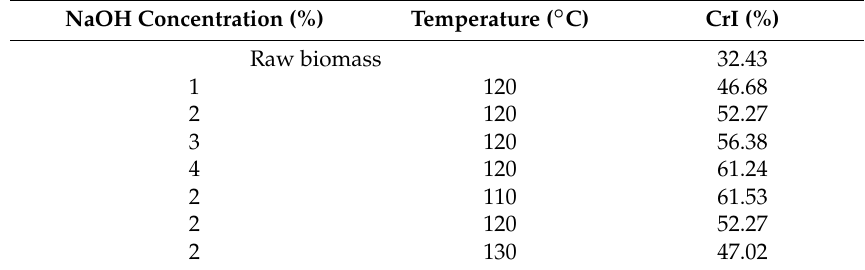
Table 4. The crystallinity index (CrI) of the raw and autoclave-assisted alkaline pretreated C. barbata . NaOH Concentration (%) Temperature ( ◦ C) CrI (%) Raw biomass